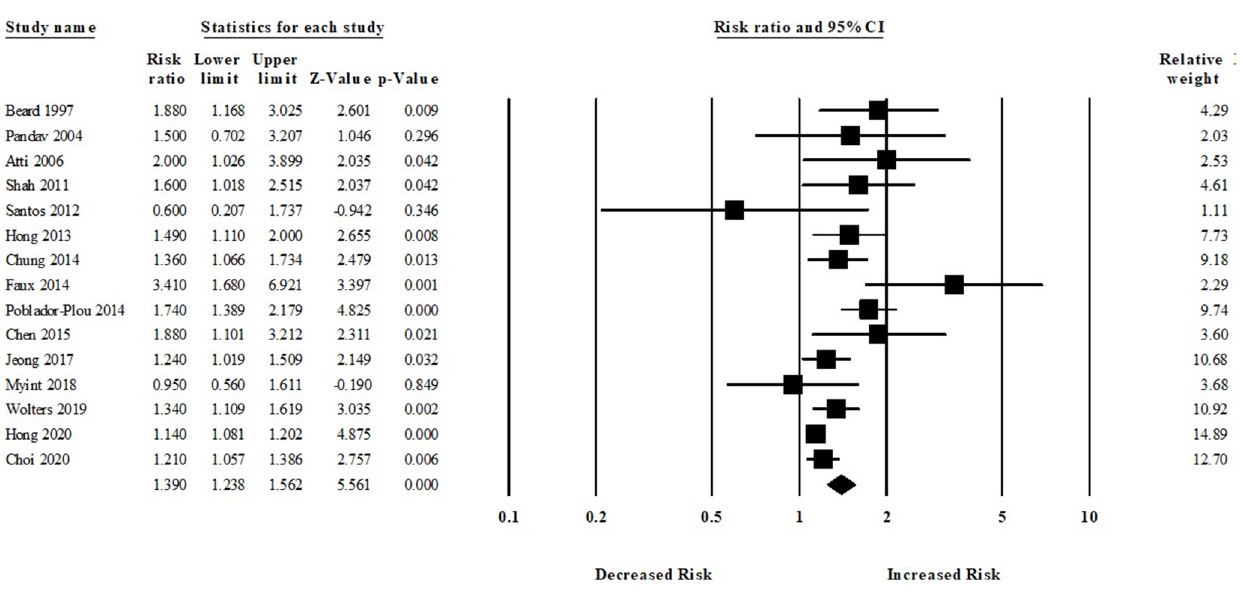
Figure 3. Association between anemia and all-cause dementia [18,19,21,23–29,32–36]. Moreover, six studies assessed the risk of Alzheimer’s disease (AD) in patients with or without anemia. The patients with anemia were significantly associated with an increased risk of AD (aRR, 1.59 (95% CI, 1.18–2.13; p = 0.002)) (Figure 4). There was a moderate risk of heterogeneity among the studies (Q = 10.24, I 2 = 51.18, τ 2 = 0.06).